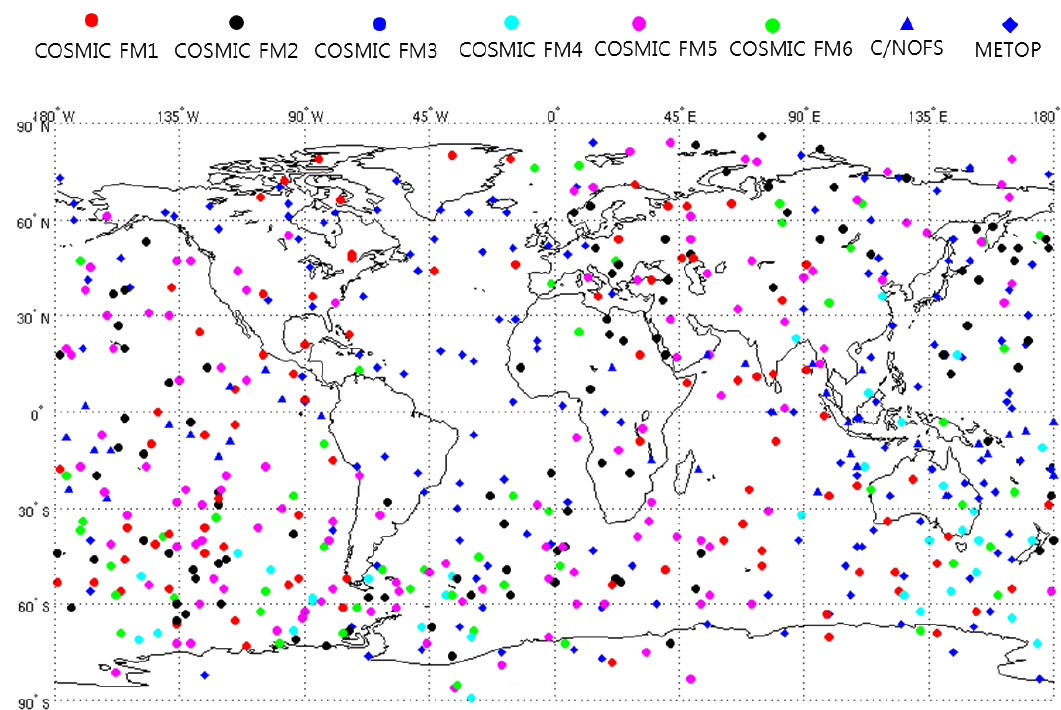
Figure 2. Six-hour coverage of the GPS radio occultation events on 7 November 2012. The total number of profiles is 591.